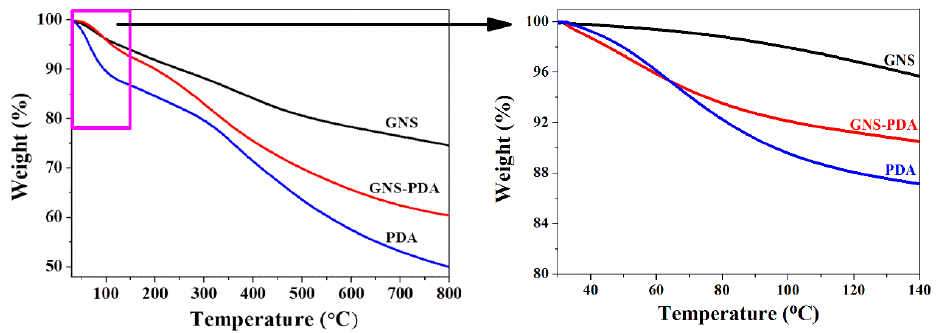
Figure 3. TG curves of GNS, GNS-PDA, and pure PDA.